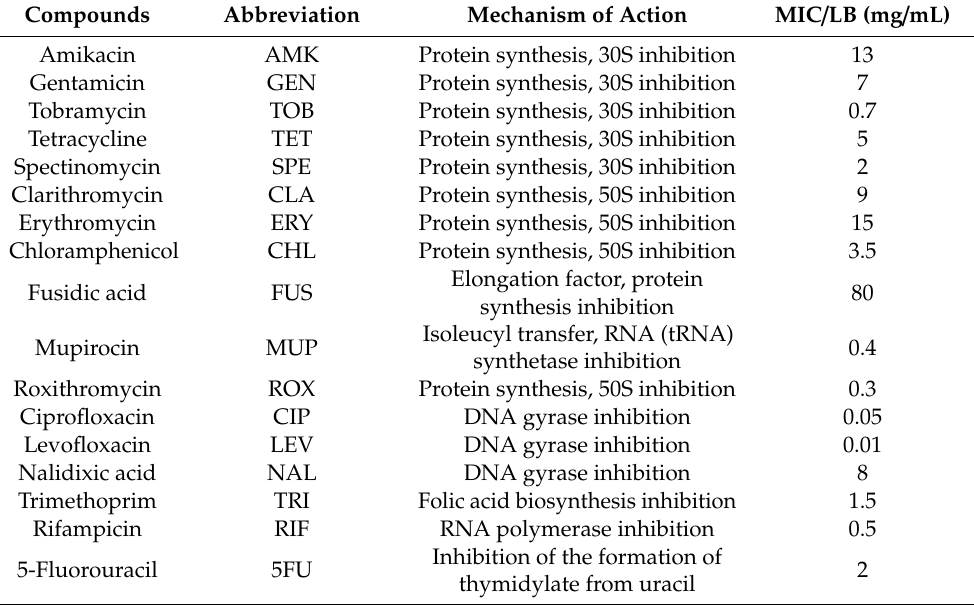
Table 1. List of antibiotics used in the study with minimum inhibitory concentration (MIC) values. Compounds Abbreviation Mechanism of Action MIC / LB (mg / mL) Amikacin AMK Protein synthesis, 30S inhibition Gentamicin GEN Protein synthesis, 30S inhibition TOB Protein synthesis, 30S